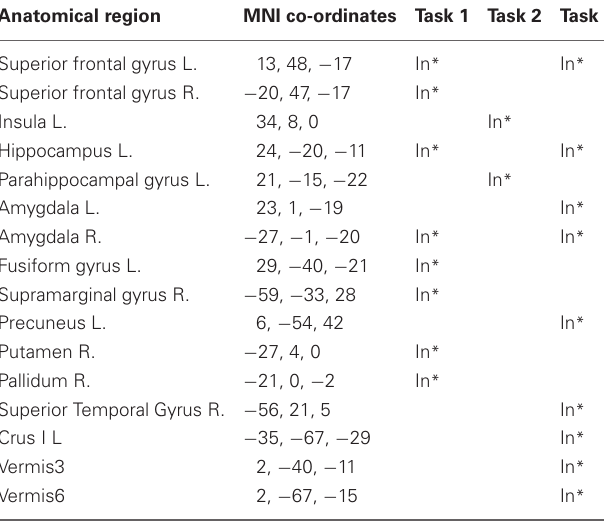
FIGURE 14 | Network modularity following the visuo-motor adaptation learning task, in the same format as Figure 12. However, this figure highlights the increased connection to the right SMA in Rest 2. Color code for modules are Cyan, sensory-motor and prefrontal; Dark Blue, fronto-parietal; Red/Pink, cerebellar; Yellow, visual; Green, subcortical.